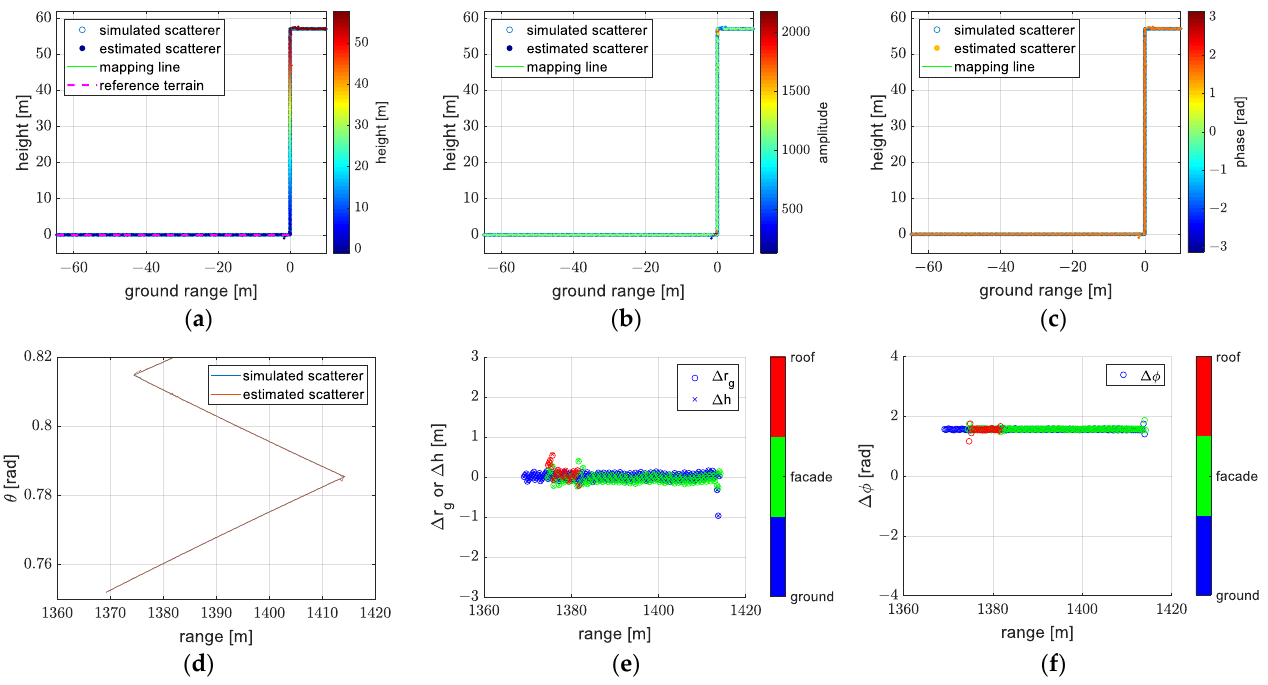
Figure 16. The reconstruction obtained under model 1 (the exact form of the planar wavefront model) after transformation: ( a ) reconstruction with colors denoted as height, ( b ) reconstruction with colors denoted as amplitude, ( c ) reconstruction with colors denoted as phase, ( d ) the off-nadir angle of the reconstruction, ( e ) the error of the ground range and height, ( f ) the error of the phase.